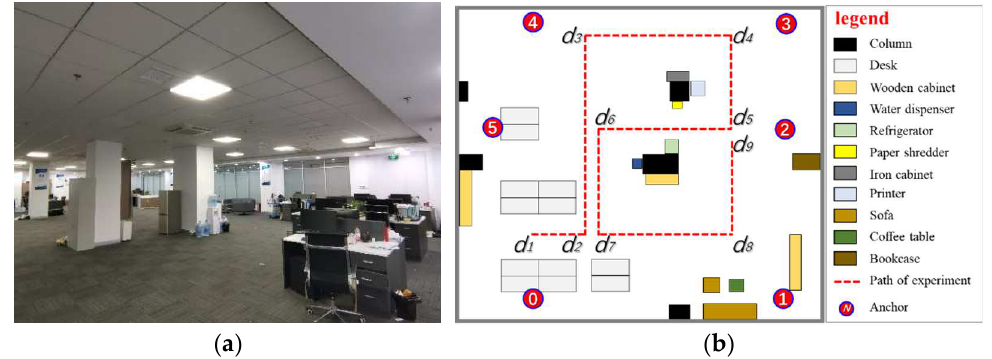
Figure 7. Experimental Site 2 environment and experimental route. ( a ) Site environment and ( b ) site plan and experimental path.